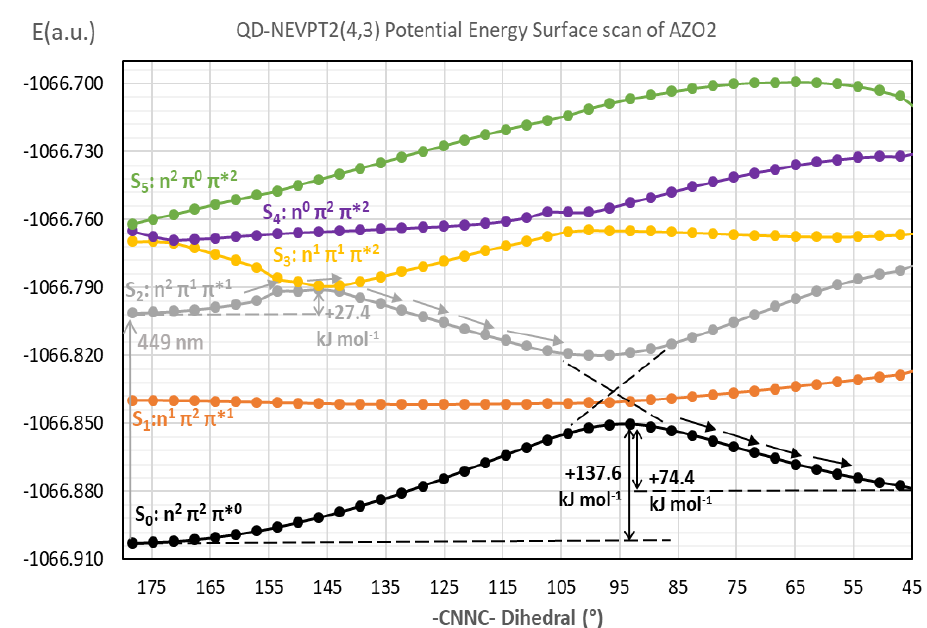
Figure 8. QD-NEVPT2(4,3) // SA6-CASSCF(4,3) / def2-TZVP potential energy surface scan of the six lowest lying singlet states of AZO2. S 2 and S 3 states cross at approximately (CNNC) = 150°and 6.6 kcal/mol above the S 2 minimum.